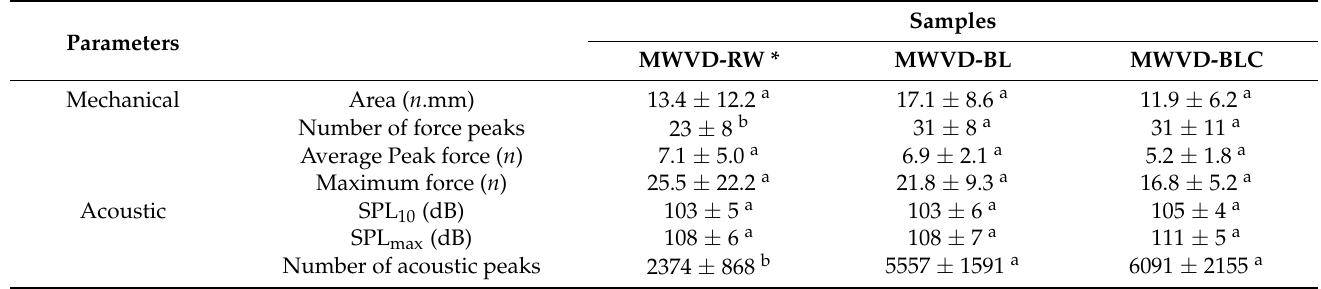
Table 3. Parameters obtained in the acoustic–mechanical test for dried samples (MWVD-RW, MWVD- BL, and